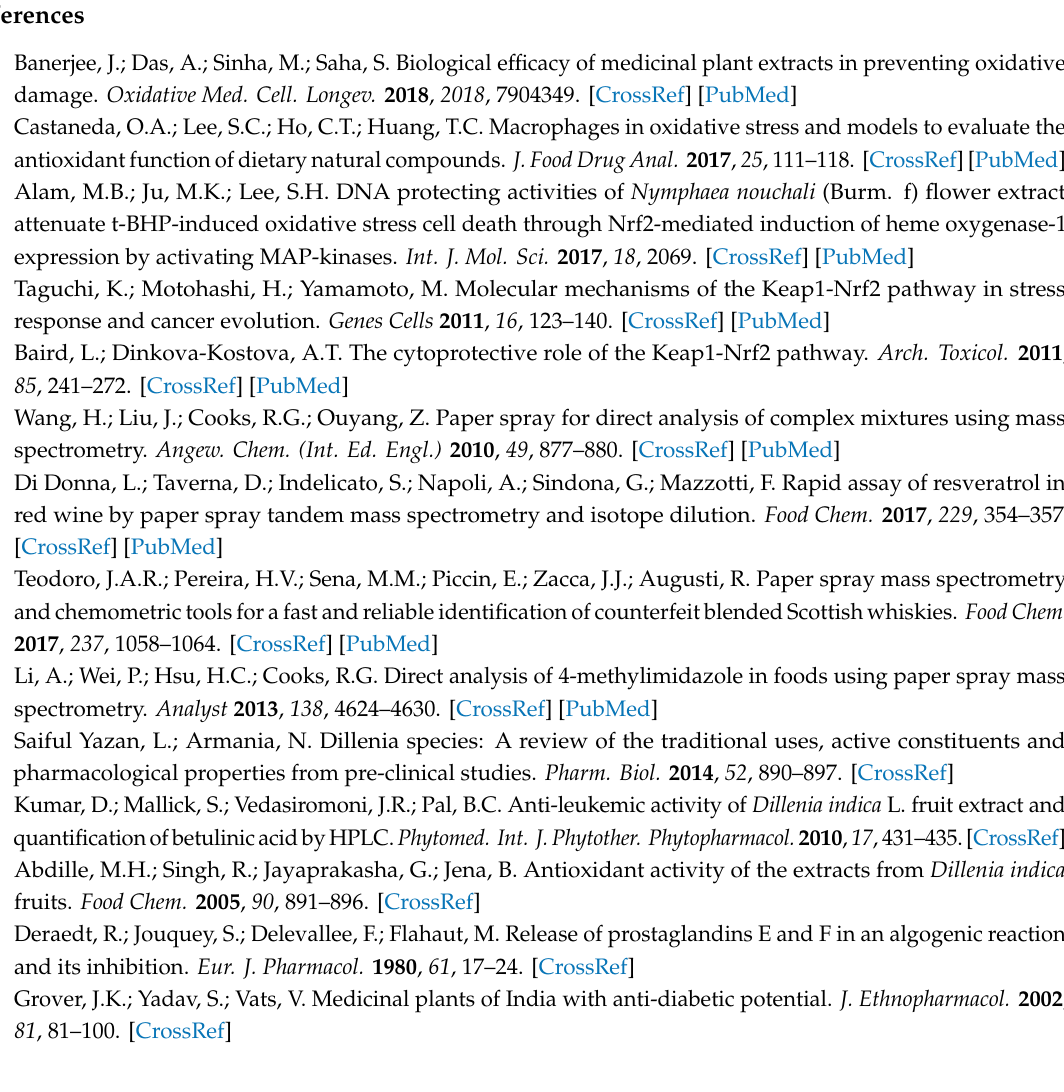
Figure S1: Mass fragmentation of nitrogen compounds in DIB extracts. Figure S2: Mass fragmentation of flavonoids in DIB extracts. Figure S3: Mass fragmentation of phenolic acids in DIB extracts. Figure S4: Mass fragmentation of ethyl maltol, 11-dodecenoic acid, and the triterpenoid nutriacholic acid in DIB extracts. Figure S5: DPPH and ABTS radical-scavenging activities of various organic and aqueous DIB extracts. Figure S6: Superoxide and hydroxyl radical-scavenging activities of various organic and aqueous DIB extracts. Figure S7: CUPRAC and FRAP activities of various organic and aqueous DIB extracts. Figure S8: Total phenol (A) and flavonoid (B) content of various organic and aqueous DIB extracts. Figure S9: Cell viability of DIBEt. Table S1: List of primer sequences used in this study. Table S2: List of antibodies used in this